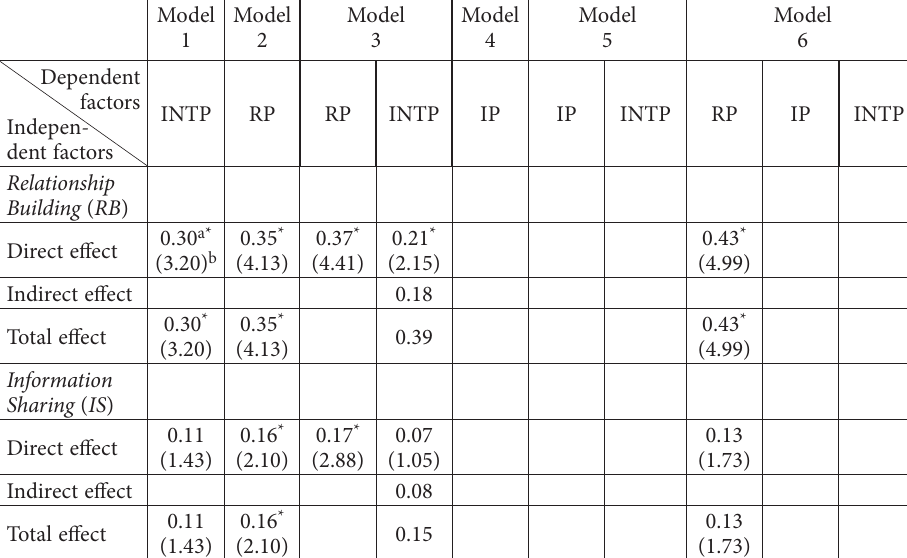
Table 5. The analysis of latent variables for model